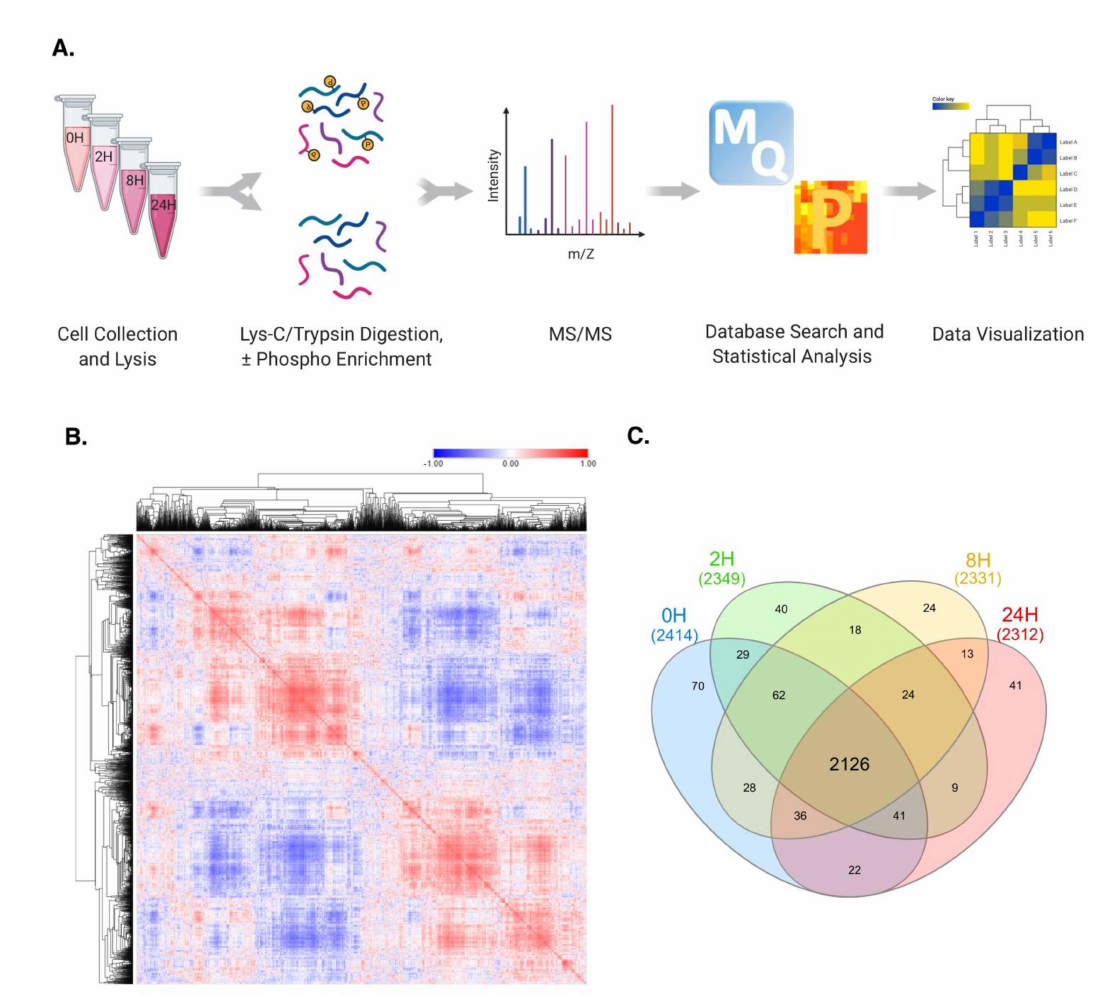
Figure 1. Global proteomic analysis of TNF α -treated murine hepatocytes. ( A ) Schematic representation of the exper- imental workflow. Cells were collected at 0H, 2H, 8H, and 24H, proteins were extracted and subsequently digested with Lys-C/Trypsin. A fraction of the total peptides was utilized for global proteomics, and the remainder was used for phosphoenrichment. Raw LC–MS/MS data were searched for with the MaxQuant software, and analyses were performed in the Perseus platform. ( B ) Pearson’s correlation profile of all quantified proteins. Red hue indicates higher correlation scores, while blue hue corresponds to lower correlation values. ( C ) Venn diagram representation of all quantified proteins identified in each time point. A total of 2126 proteins were quantified in all four time points, indicating a highly consistent data acquisition and sample